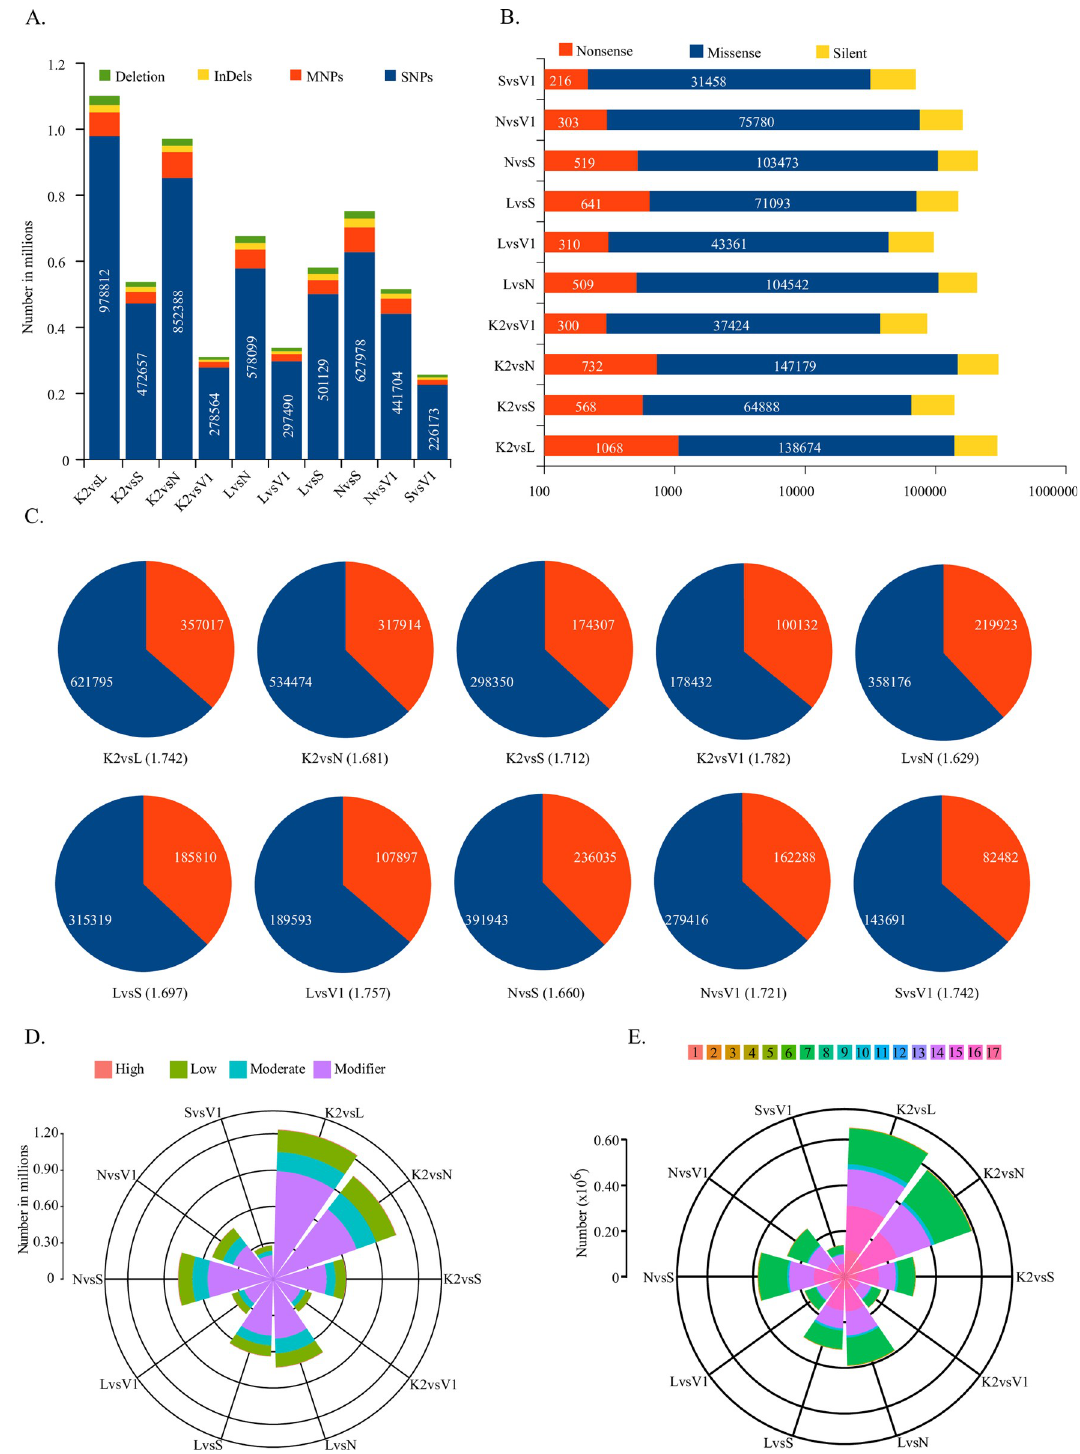
Fig 4. Figure showing the results of variant finding and their effect on transcriptome. A) Bar graph showing the number of variants from different categories i.e. SNP, MNP, Insertions and deletions. B) Horizontal bars showing the number of SNPs having effects like non-sense, miss-sense and silent mutations on a log scale. C) Pie charts showing the SNPs type into transition (blue shade) and transversion events (red shade). D) Polar graph with stacked columns showing distribution of SNPs into their strength of their effect on coding sequences. E) Polar stacked columns showing the Effect of variants. Coloured legends details are as 1. Codon